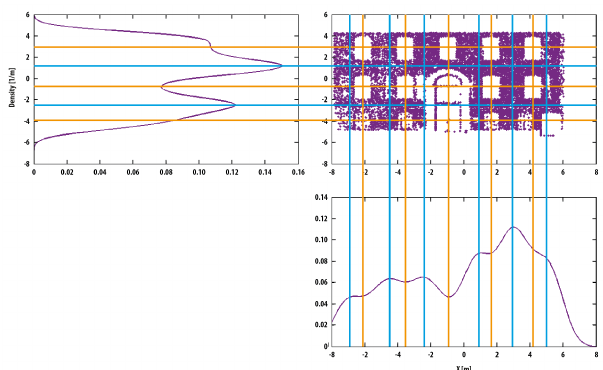
Figure 4: KDE of the consensus set of the fac¸ade main plane of the Frankenforst manor in Vinxel/ Germany. The extrema are incorporated for the floor-wise and column-wise segmentation of the fac¸ade and for the identification of openings.